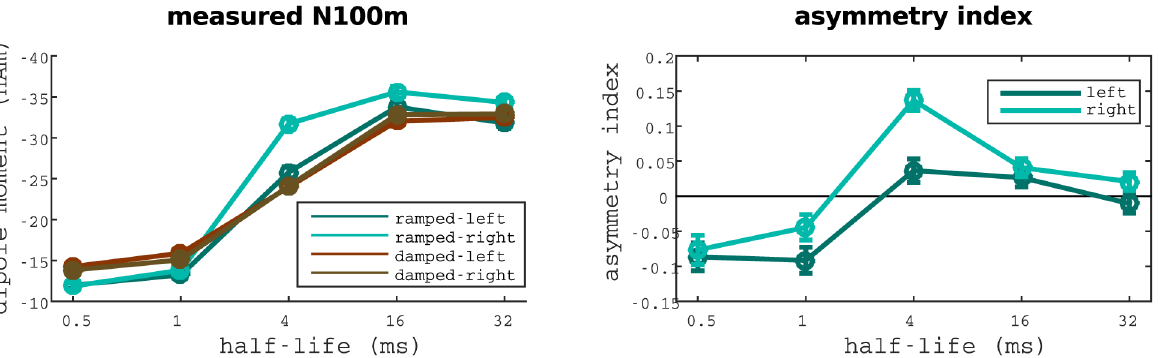
Fig 6. Inter-hemispherical differences observed between the fields evoked by ramped and damped sinusoids. Comparison between the fields evoked in left and right hemispheres for ramped and damped stimuli. N100m ’ s magnitude is plotted in the left panel. Corresponding asymmetry indices are displayed in the right